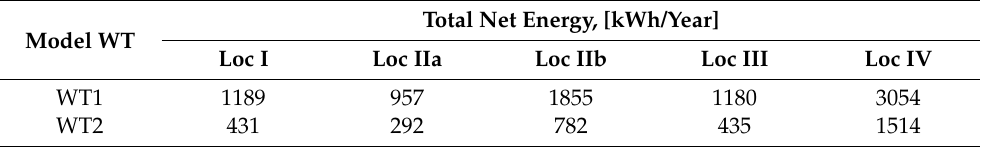
Figure 14. Amount of energy supplied to the power grid by the wind turbine WT2. Table 2. Annual amount of energy delivered to the power grid by wind